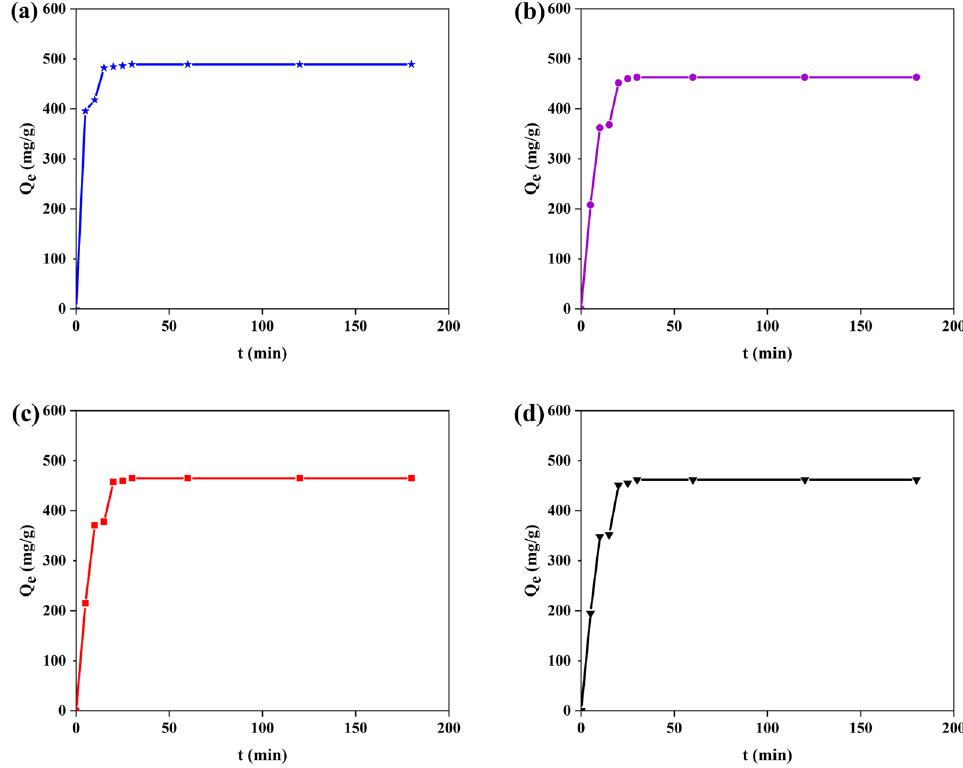
Fig. 7 a Adsorption kinetics curves of PAA/PAM/[DMAEMA]MA hydrogel on MB. b RHB. c CR. d